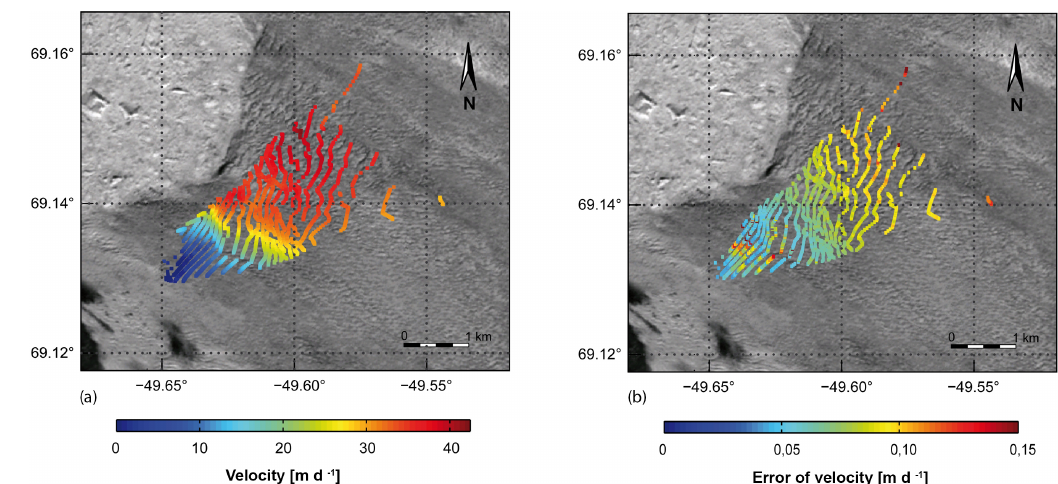
Figure 15. Horizontal velocity field (a) and corresponding error values (b) (example: Jakobshavn Isbræ, May